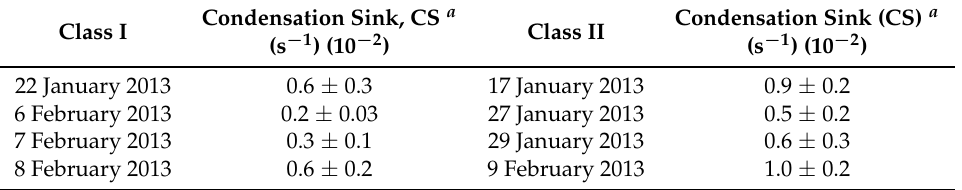
Table 2. Condensation sink during the Class I and Class II events during the MUMBA